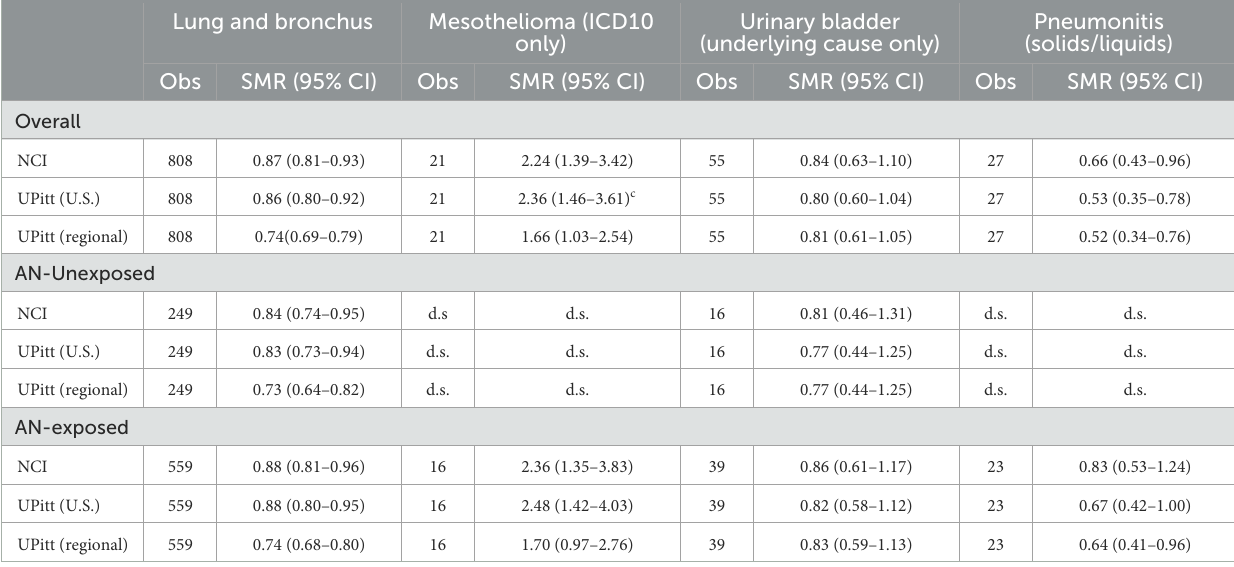
TABLE 1 Observed deaths, NCI U.S. rate-based SMRs a,b , UPitt U.S. and regional rate-based SMRs b for key causes of death by AN exposure, full NCI AN cohort, 1942–2011. Lung and bronchus Mesothelioma (ICD10 Urinary bladder only) (underlying cause